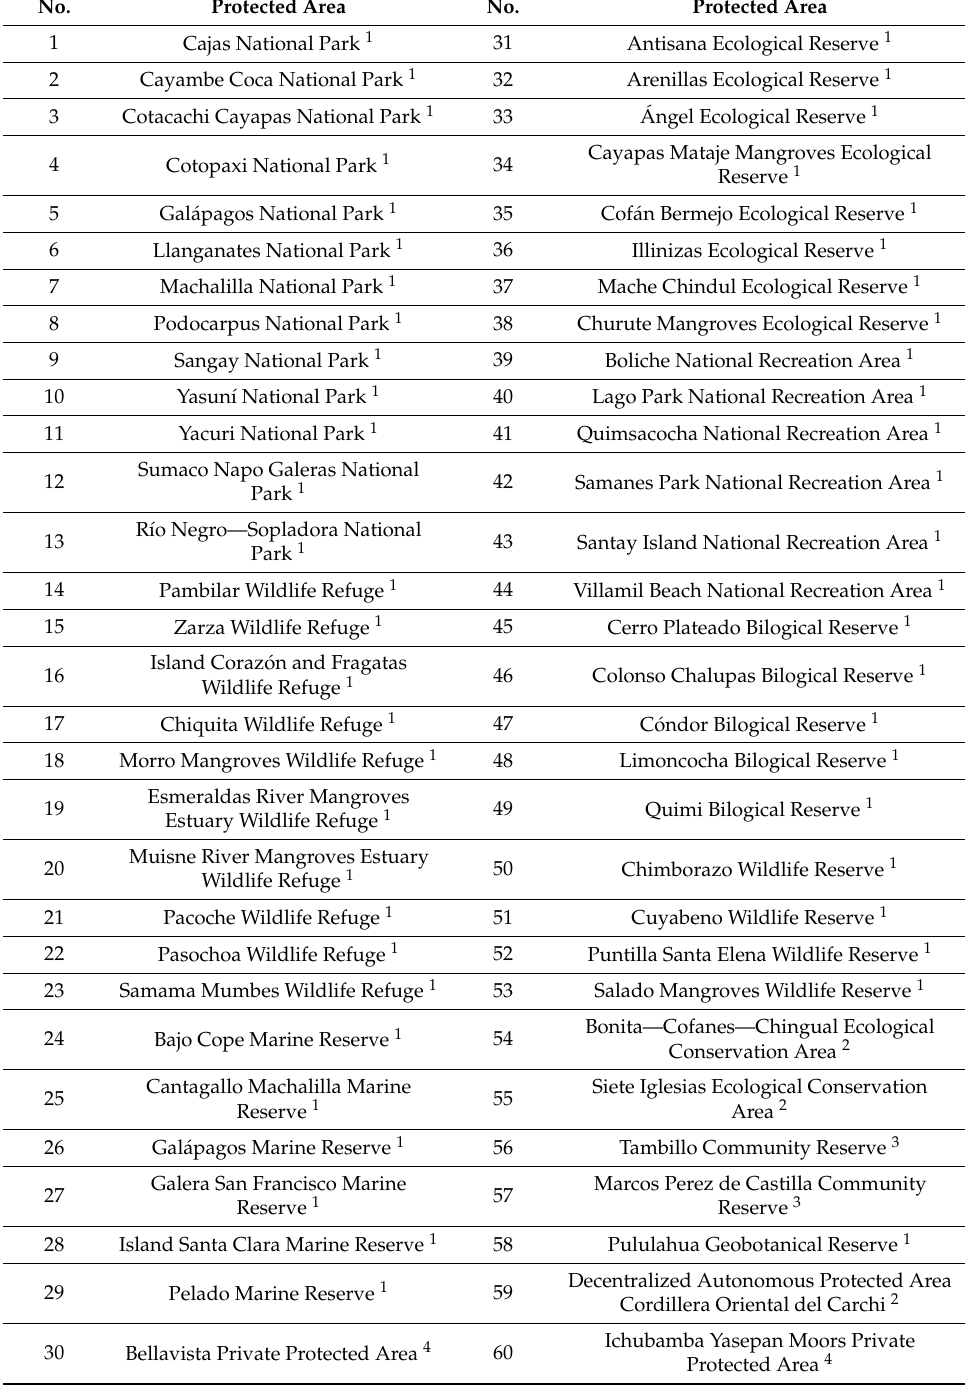
Table 4. The list of natural protected areas under National System of Natural Protected Areas (NSNPA) of Ecuador